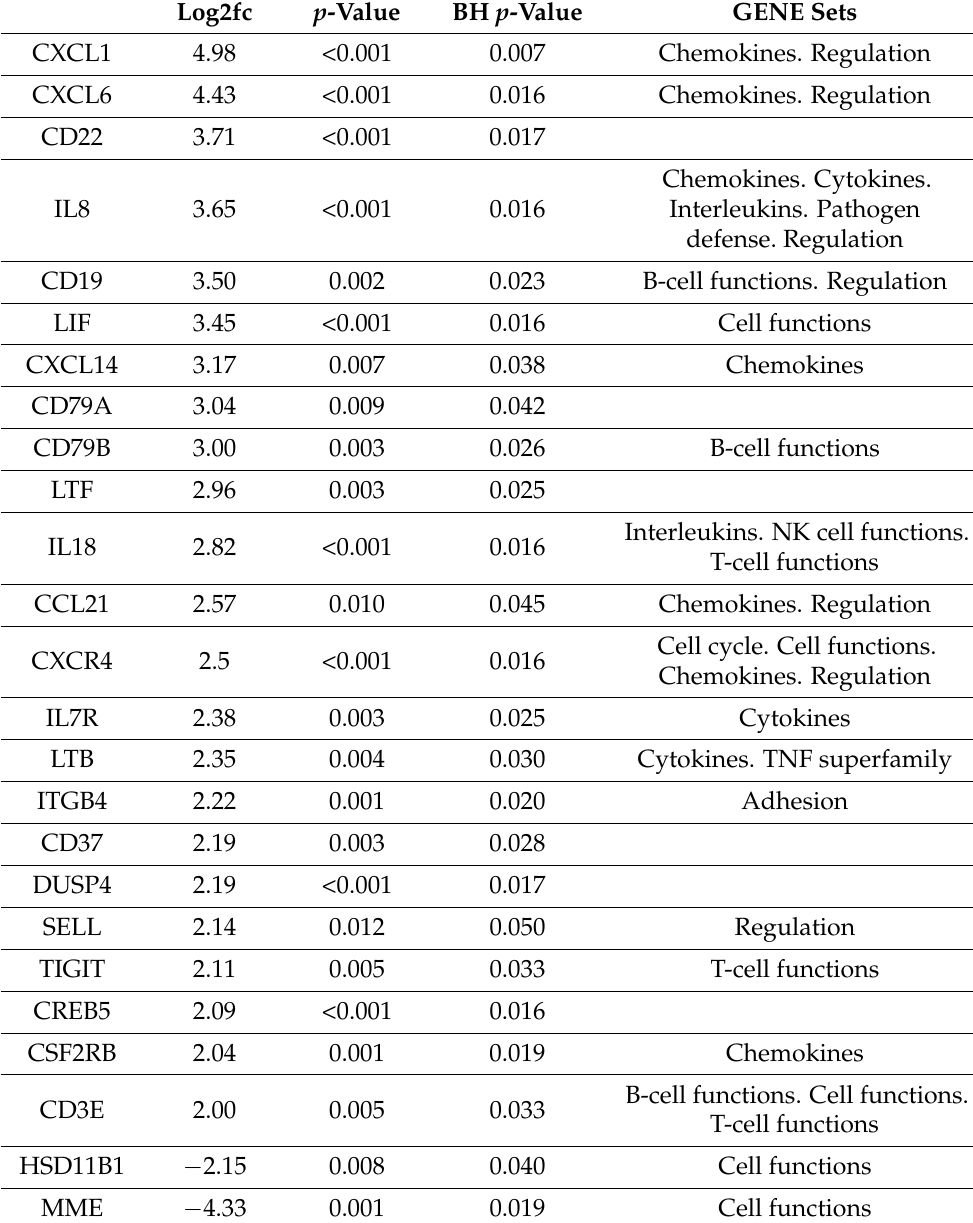
Table 2. The strongest differentially expressed genes among TACE responders and